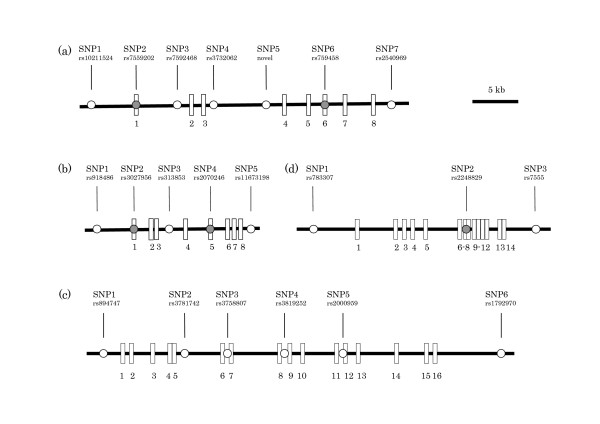
Genomic organizations of each gene and locations of the SNPs. (a) SLC1A4 spans over 34 kb and is composed of 8 exons. (b) SLC1A5 spans over 14 kb and is composed of 8 exons. (c) SLC6A5 spans over 55.6 kb and is composed of 16 exons. (d) SLC6A9 spans over 19.8 kb and is composed of 14 exons. Exons are shown as vertical bars with exon numbers. SNPs we analyzed are indicated by circles. Exonic SNPs are indicated by filled circles.